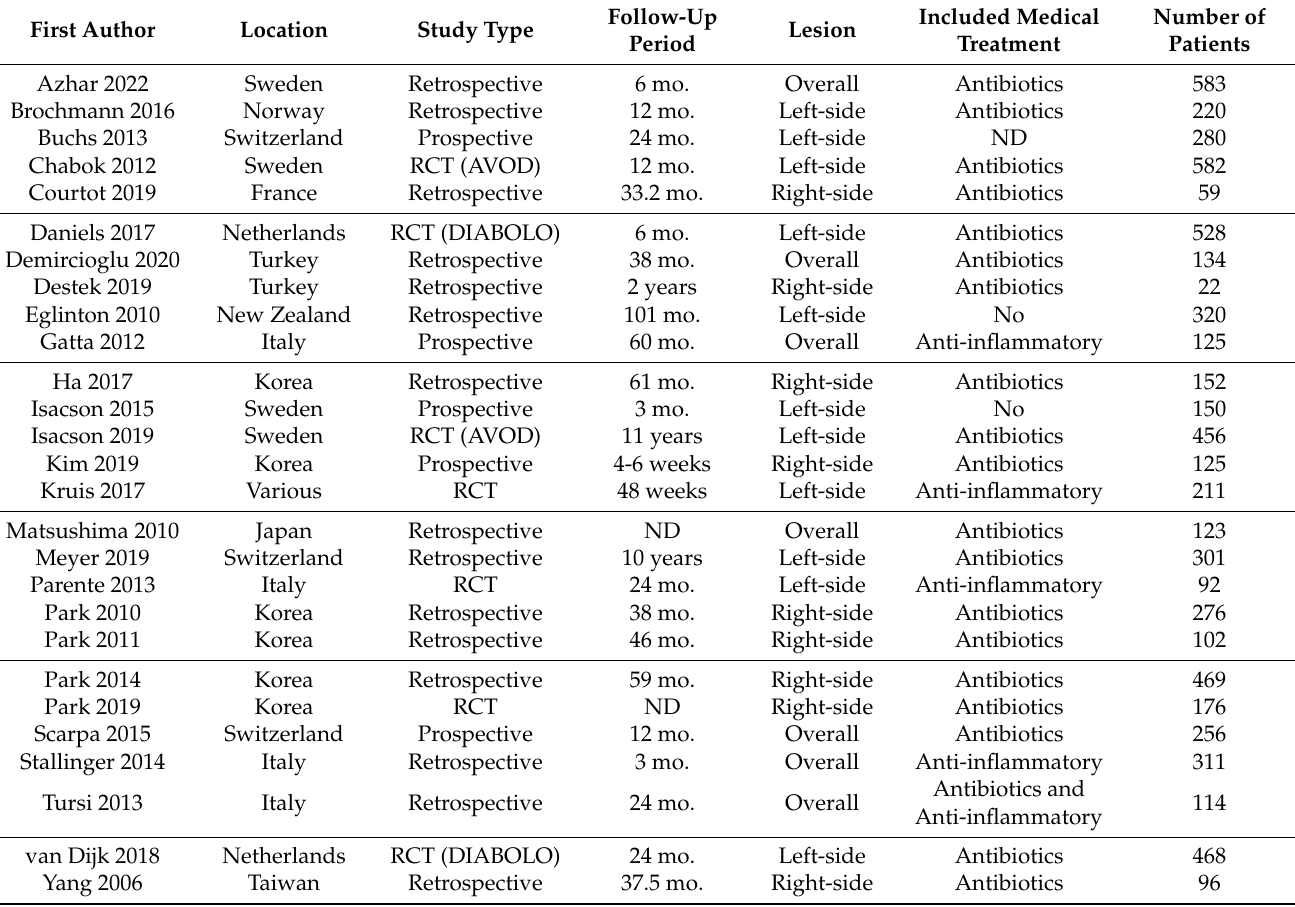
Table 1. Main characteristics of eligible